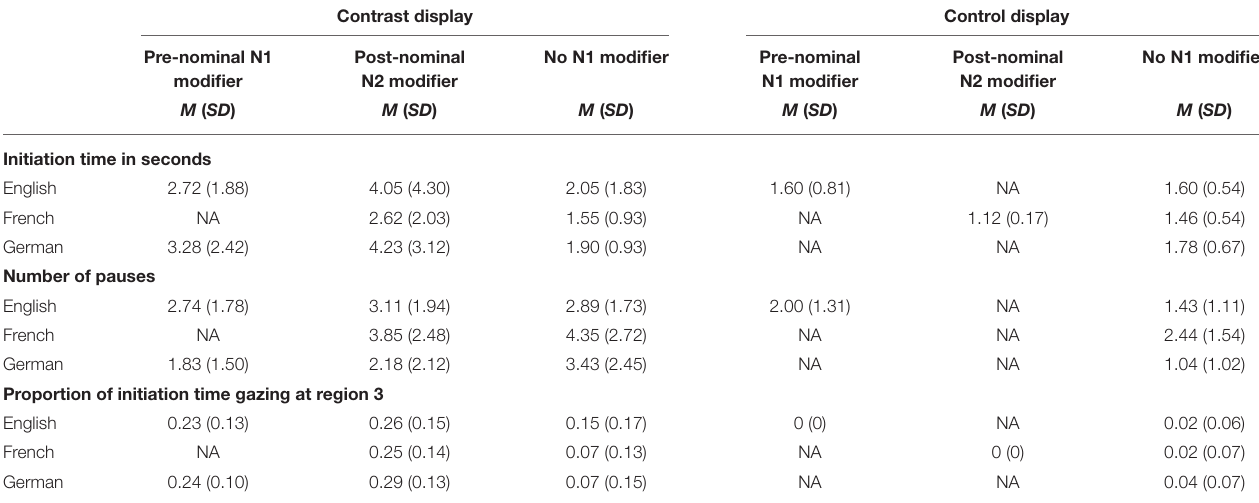
TABLE 3 | Descriptive statistics (means and standard deviations) for the three dependent variables, by language, display type (contrast vs. control), and N1 modification type. Contrast